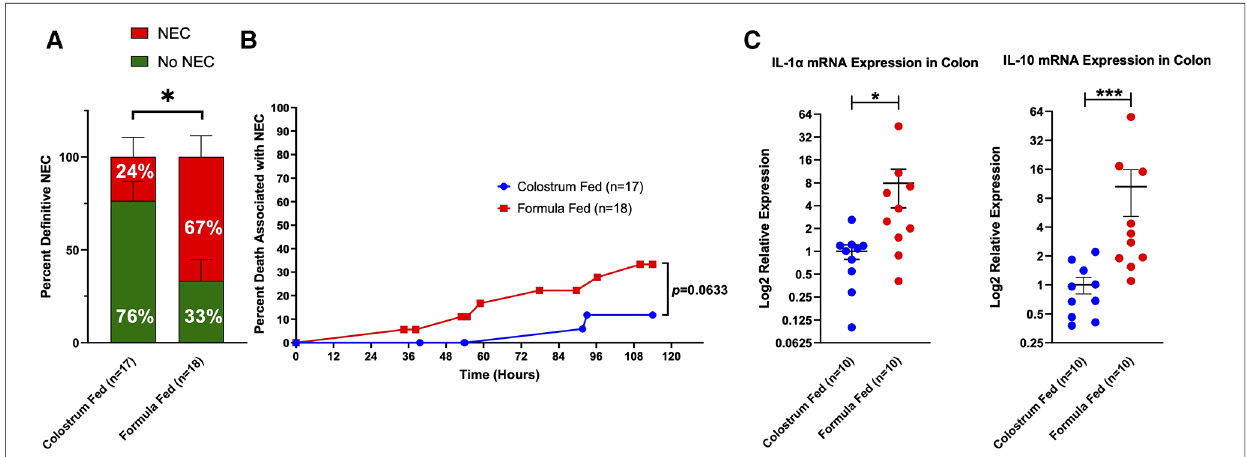
FIGURE 4 De fi nitive NEC (D-NEC) incidence, percent death associated with NEC, and colonic in fl ammation. ( A ) Incidence of D-NEC. Statistical analysis was carried out using the Mann – Whitney U -test (* p =0.0176); ( B ) Percent Death Associated with NEC. Each data point represents death of a piglet that was determined to have D-NEC. Piglets that survived to the end of the experiment and were found to have D-NEC were not included in this graph; ( C ) Colonic In fl ammation. Expression levels of IL-1 α and IL-10 mRNA in the colon were determined by qRT-PCR. Data were analyzed using the Mann – Whitney U -test (* p =0.0115, *** p =0.0005). Variability of sample means was reported as a standard error of the mean (SEM) and statistical signi fi cance was set to an α